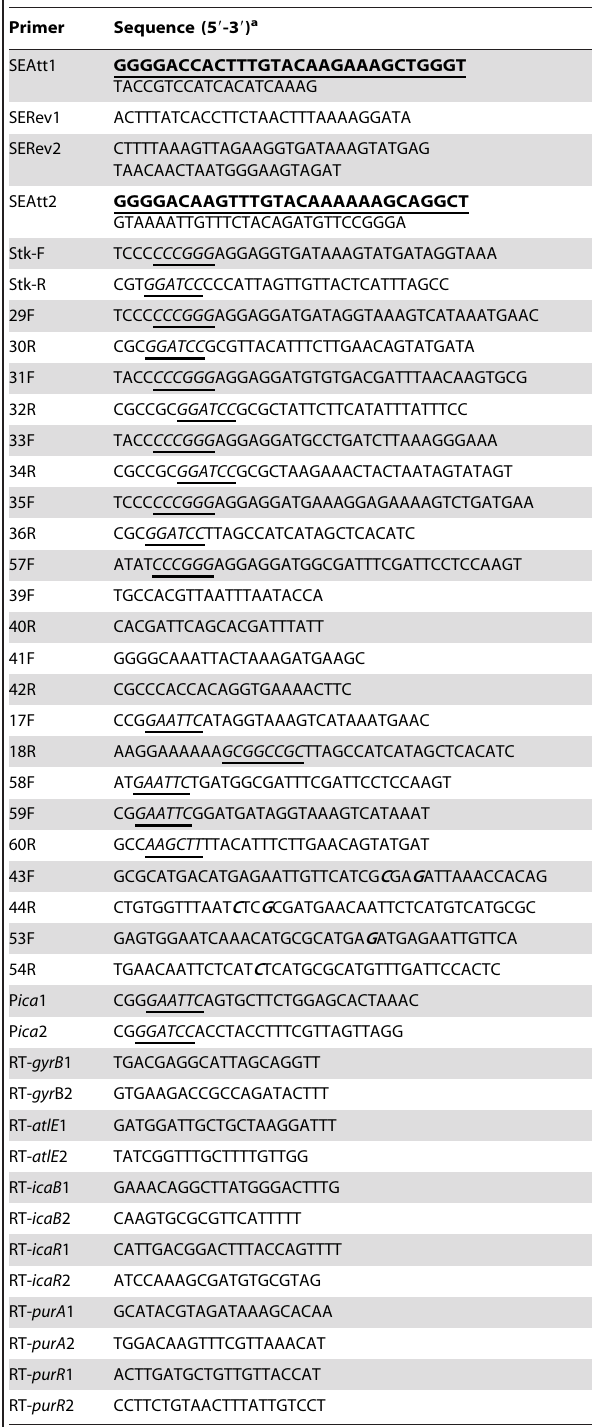
Table 2. Primers used in this